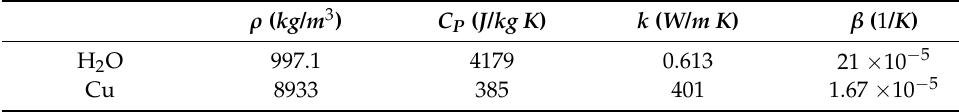
Table 1. Thermophysical characteristics of ( H 2 O ) and